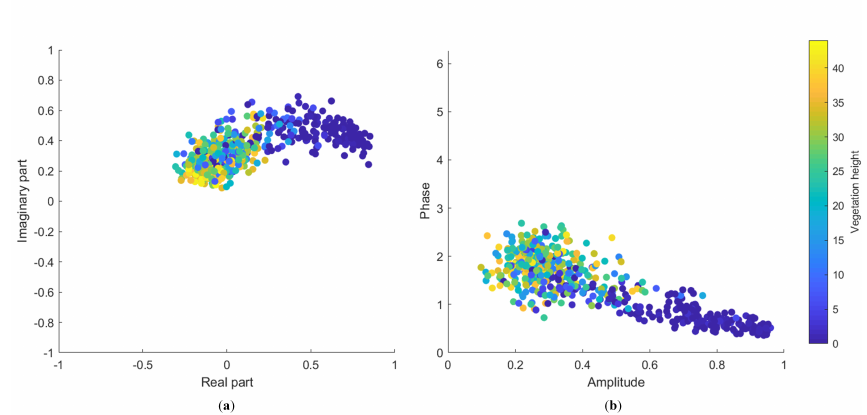
Figure 11. The distribution of observed coherence in the ( a ) CUC plane and ( b ) amplitude- phase